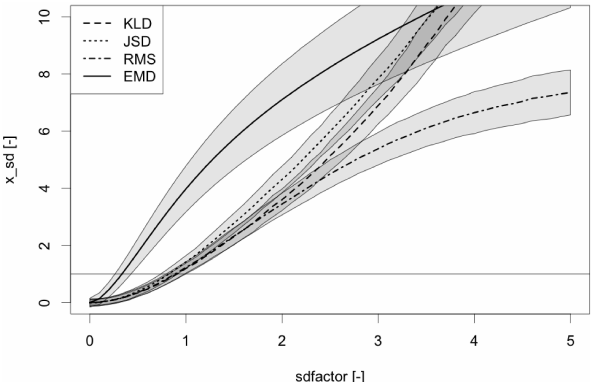
Figure 2. Results of the regime shift sensitivity test, with artifi- cially included shifts in the mean. The shift is measured in terms of the standard deviation and shown on the x-axis. The curves shows the average and their respective uncertainties of the measure x sd in Eq. (7) for 100 randomly generated data sets (without shift normally distributed with expectation mean = 0, sd = 1) for the four di ff erent